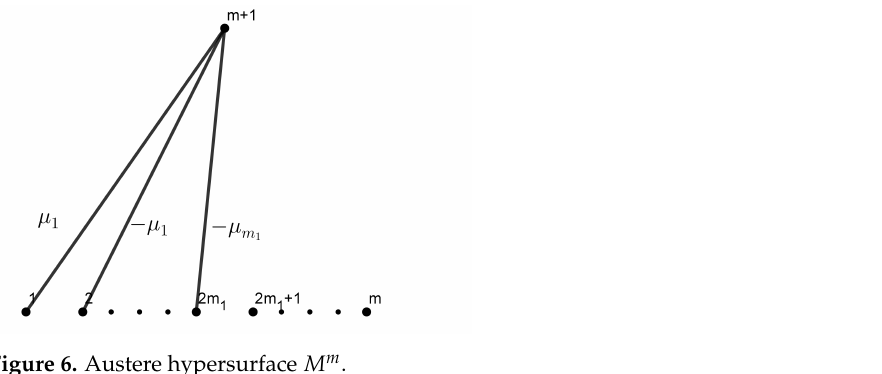
Figure 6. Austere hypersurface M m .